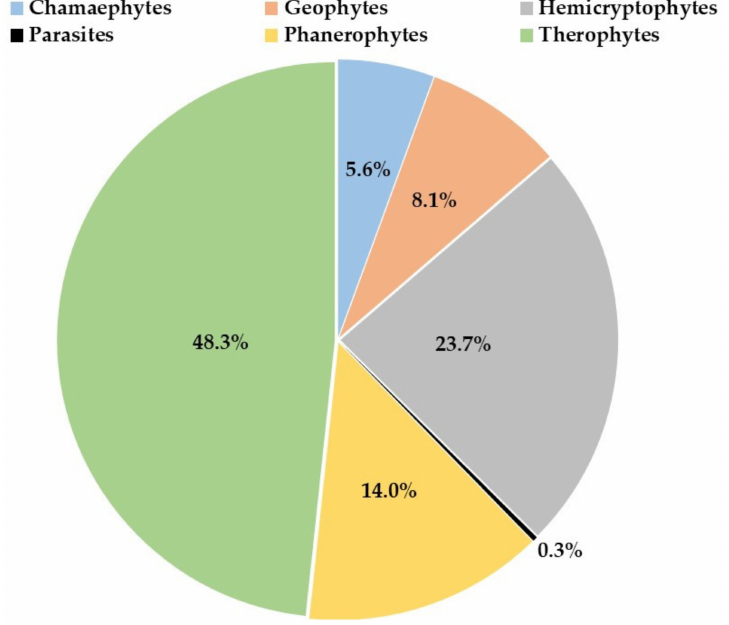
Figure 4. Life form spectrum of the flora recorded in the studied forest rangeland of Northern